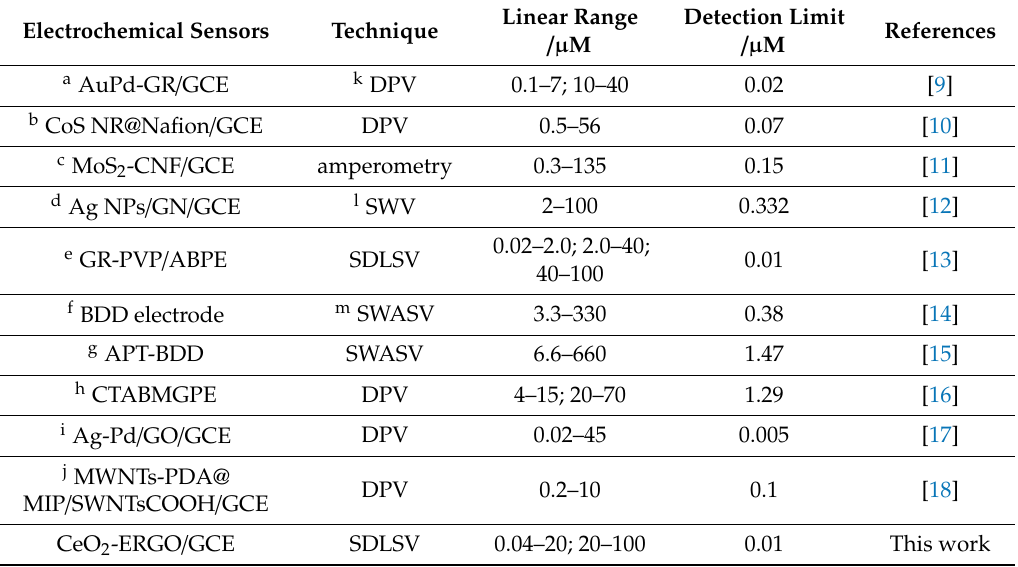
Table 2. Comparison of properties of di ff erent modified electrodes for the detection of vanillin. Electrochemical